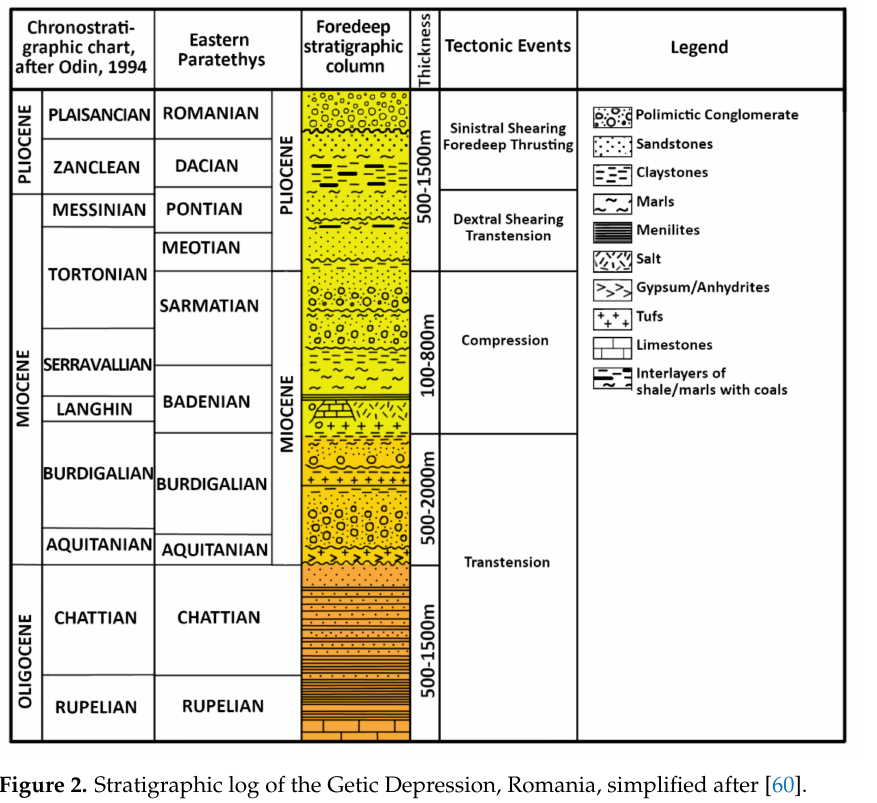
Figure 2. Stratigraphic log of the Getic Depression, Romania, simplified after [60].